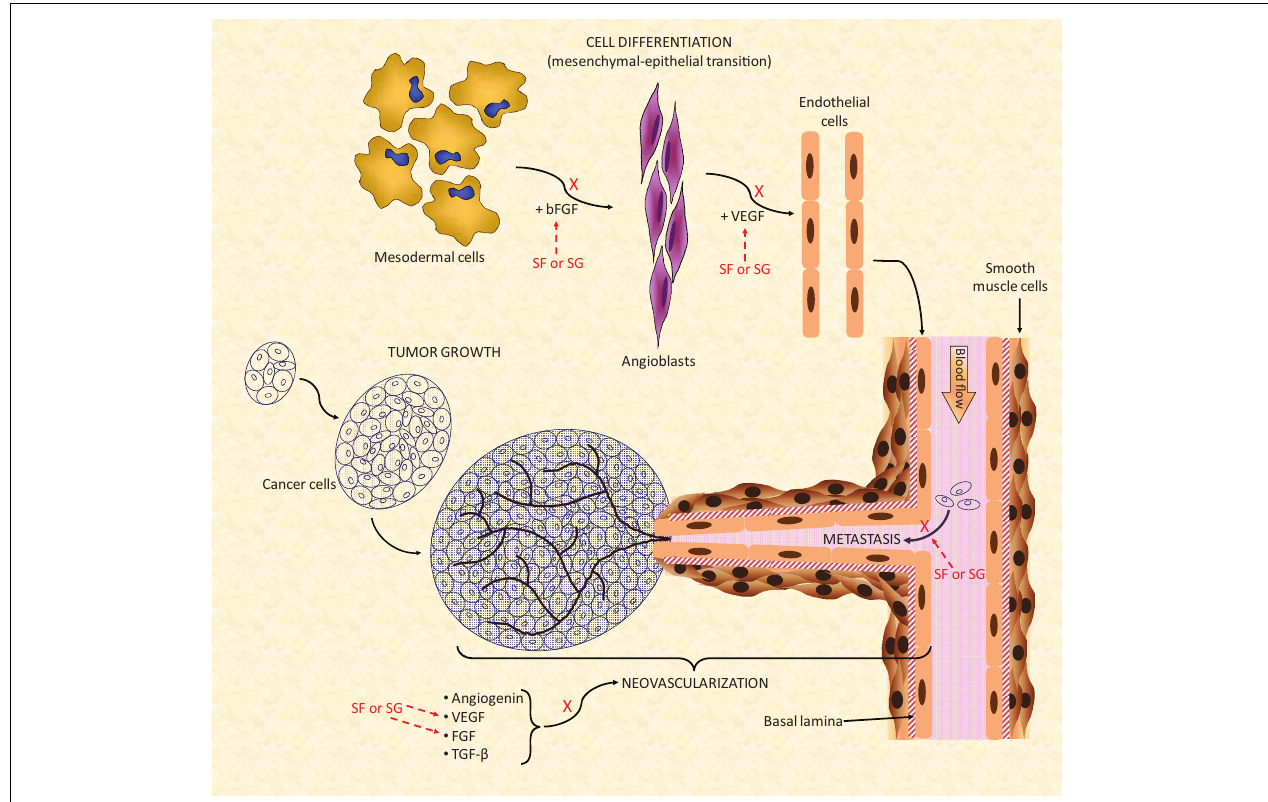
FIGURE 5 | A simplified scheme of the major biochemical mechanisms involved in tumor angiogenesis. Multiple points of action are targeted by the SFs and SGs. For a new blood vessel to be formed and to grow properly there should be a feeding of stimulatory angiogenic factors such as angiogenin, VEGF, FGF, and TGF- β for formation of the new vessels. The mesenchymal–epithelial transition must also occur concomitantly to provide newly formed endothelial cell to help the construction of the new blood ducts. In this event, modulated also by FGF molecules, mesodermal cells undergo transition until angioblasts which is the precursors of mature endothelial cells. Under the influence of VEGF, newly formed endothelial cells will be used for building the novel vessels (Lamalice et al., 2007).